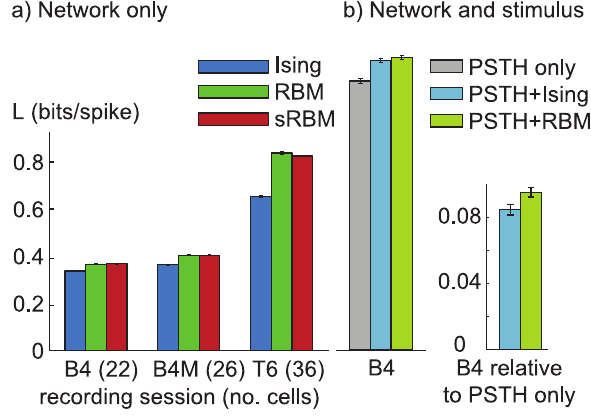
Figure 3. Model comparison using likelihood gain over the independent model. Likelihoods are normalized to bits/spike to account for different population size as well as firing rate. ( a ) The change in performance with dataset size (22 cells for session B4, 26 cells for MU, and 36 cells for T6) is thus due to additional structure captured from larger populations. B4 and T6 are spike sorted, B4M is a multiunit dataset. All three models outperform the independent model by 0.4–0.8 bits/ spike. The higher-order models with hidden units give a small (0.03–0.04 bits/spike, about 10%) improvement over the Ising model for the small datasets, growing to 0.18 bits/spike, about 28%, for the dataset with the large population size. ( b ) Including stimulus terms provides a large gain in likelihood, even the stimulus PSTH term alone outperforms the network models by a large margin for this dataset. There is still a significant gain by including coupling terms. The difference between the second order Ising model and higher-order RBM is particularly visible in the right hand plot which shows the gain relative to the PSTH only model. All error bars indicate one standard deviation over repeated estimation on different random subsets of the data for training and validation and random initializations of AIS estimation.